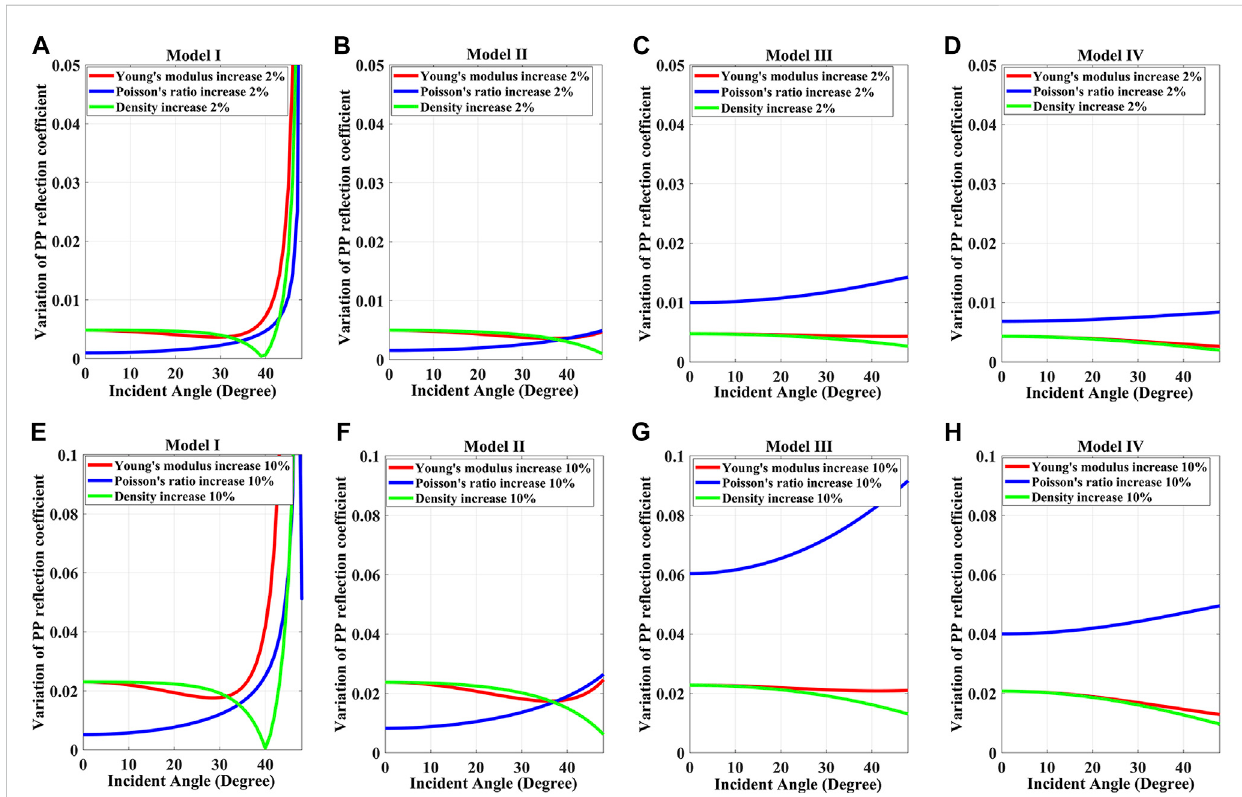
FIGURE 3 VariationoftheP-to-Pwavere fl ectioncoef fi cientsforincreasingYoung ’ smodulus(red),Poisson ’ sratio(blue),anddensity(green)ofthelowerlayer by (A – D) 2% and (E – H) 10% in four different